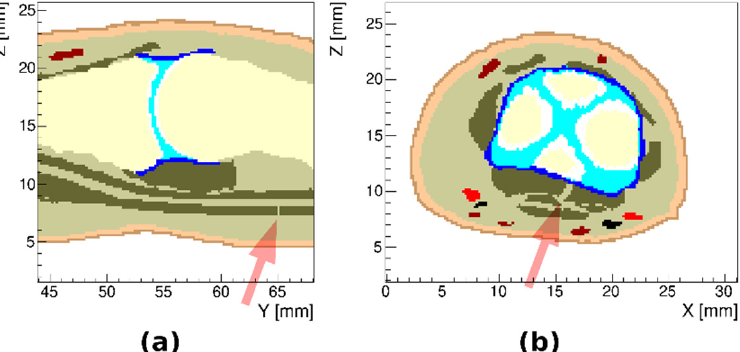
Figure 5. Two models of ruptured tendons in the index finger, first shown in transverse ( a ) and the second in sagittal ( b ) cross sections of the proximal interphalangeal joint region. The sites of ruptures are shown with an arrow.